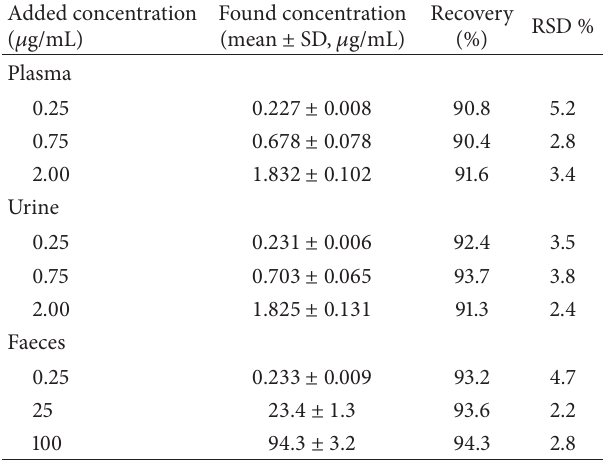
Table 2: Absolute recoveries of ergosterol in rat plasma, urine, and